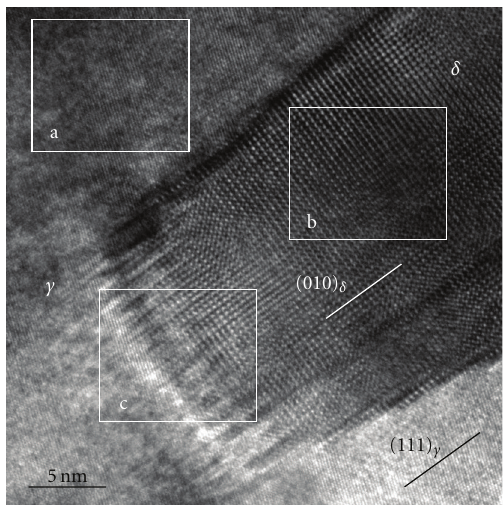
Figure 10: HRTEM image taken on a sample held for 3h at 960 ◦